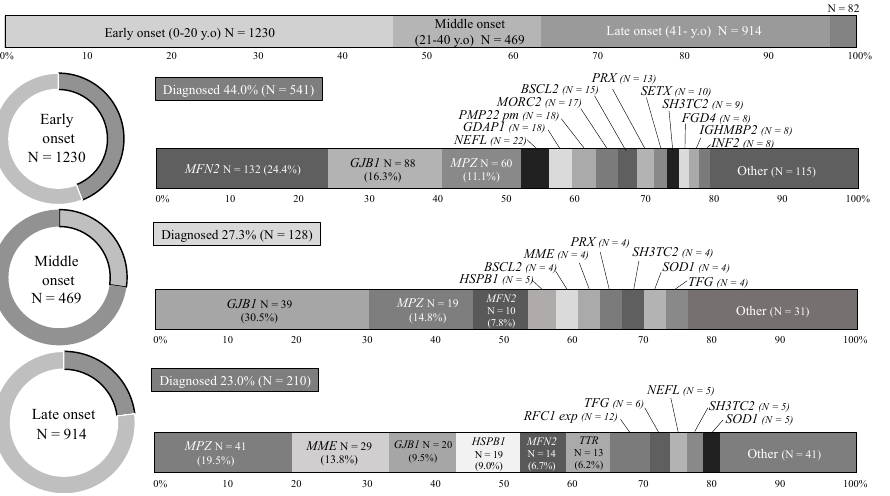
Figure 3. Genetic spectrum of each IPN subgroup with different onset ages. Diagnostic rates and genetic spectrums of IPNs with early ‐ onset (0–20 years, n = 1230), middle ‐ onset (21–40 years, n = 469), and late ‐ onset (>41 years, n = 914). pm: point mutation; exp: repeat expansion.